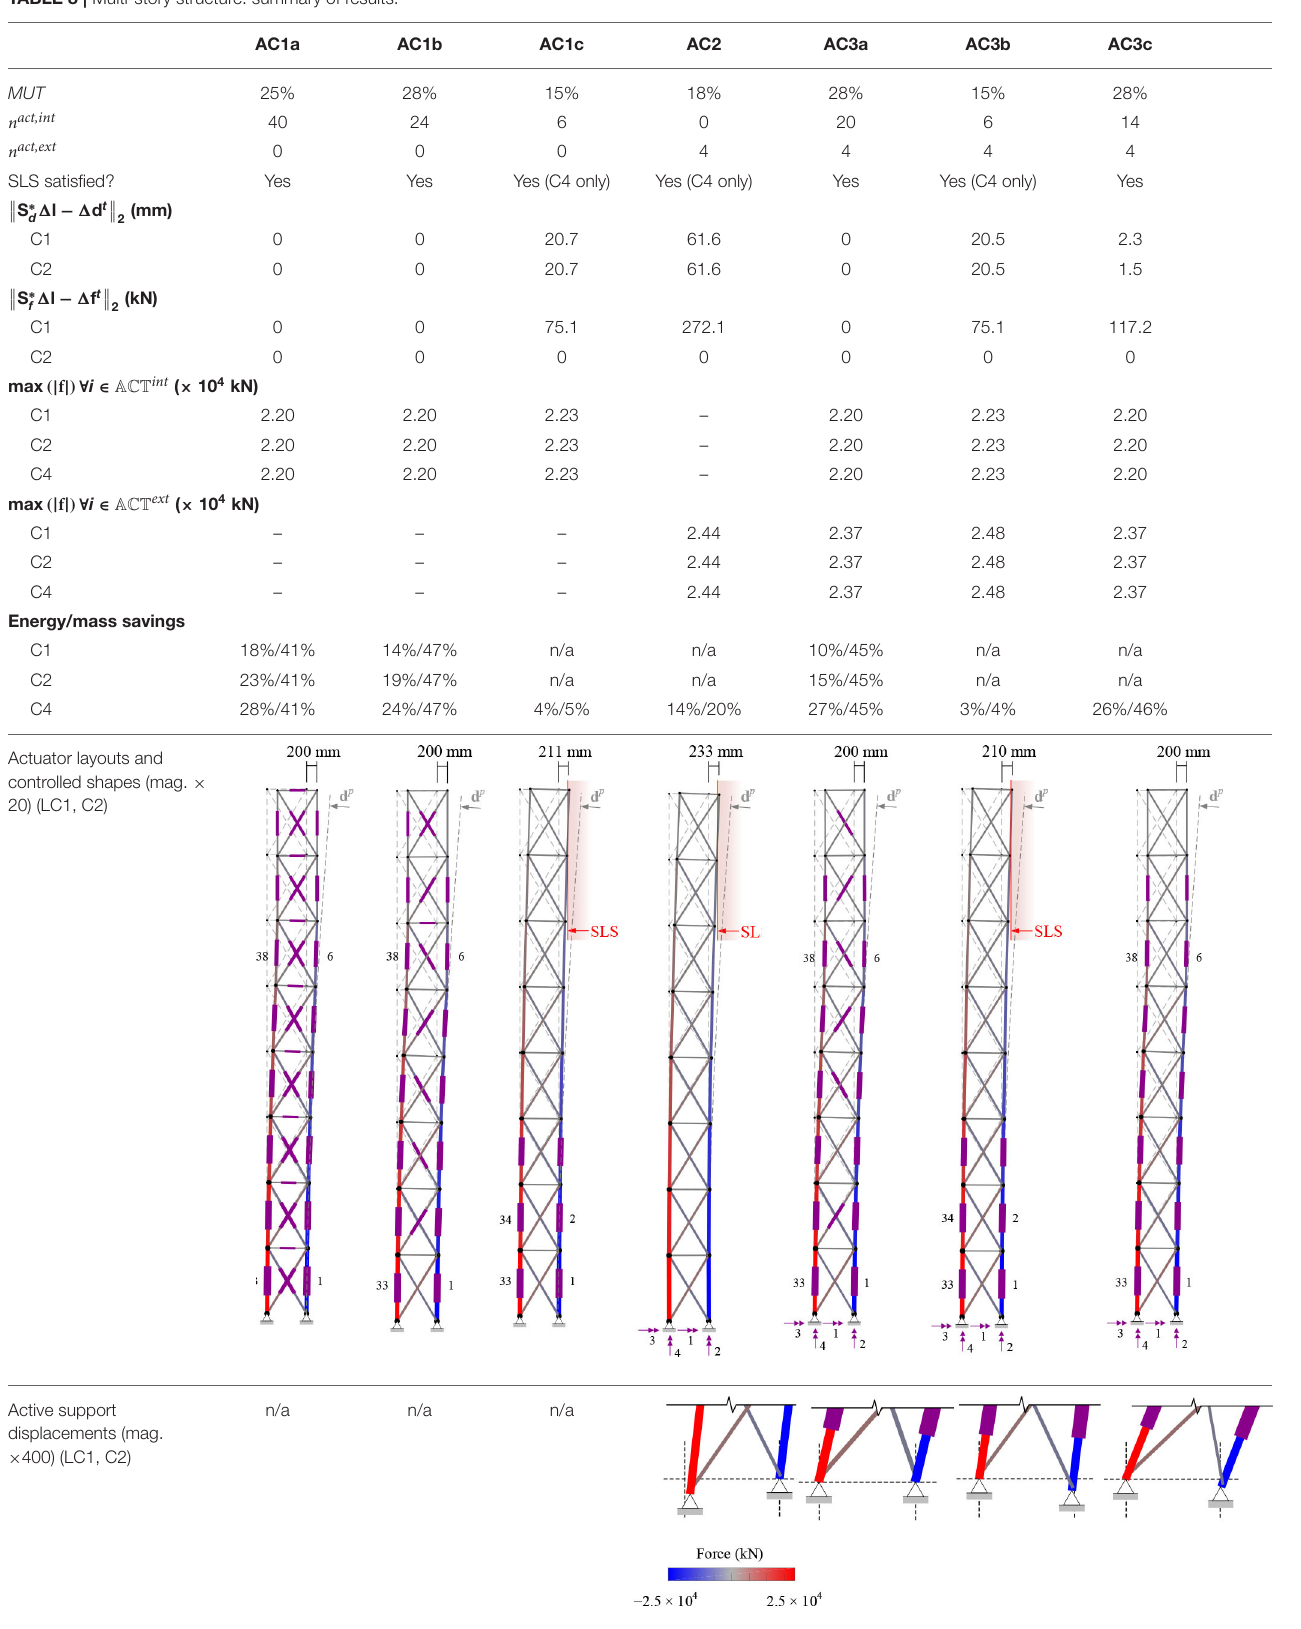
TABLE 8 | Multi-story structure: summary of